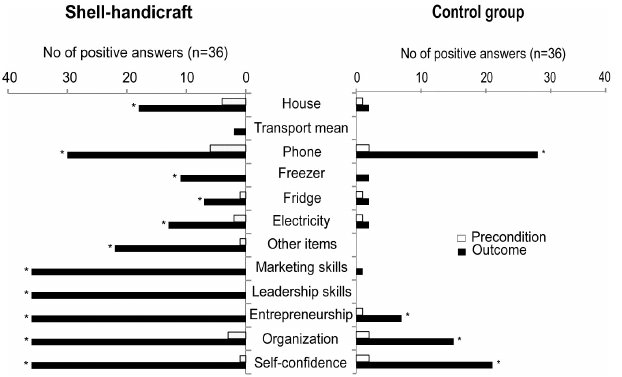
Fig. 3 . Differences over time in access to physical, human, and social resources and self-confidence for women engaged in shell-handicraft (n = 36) and control group (n =